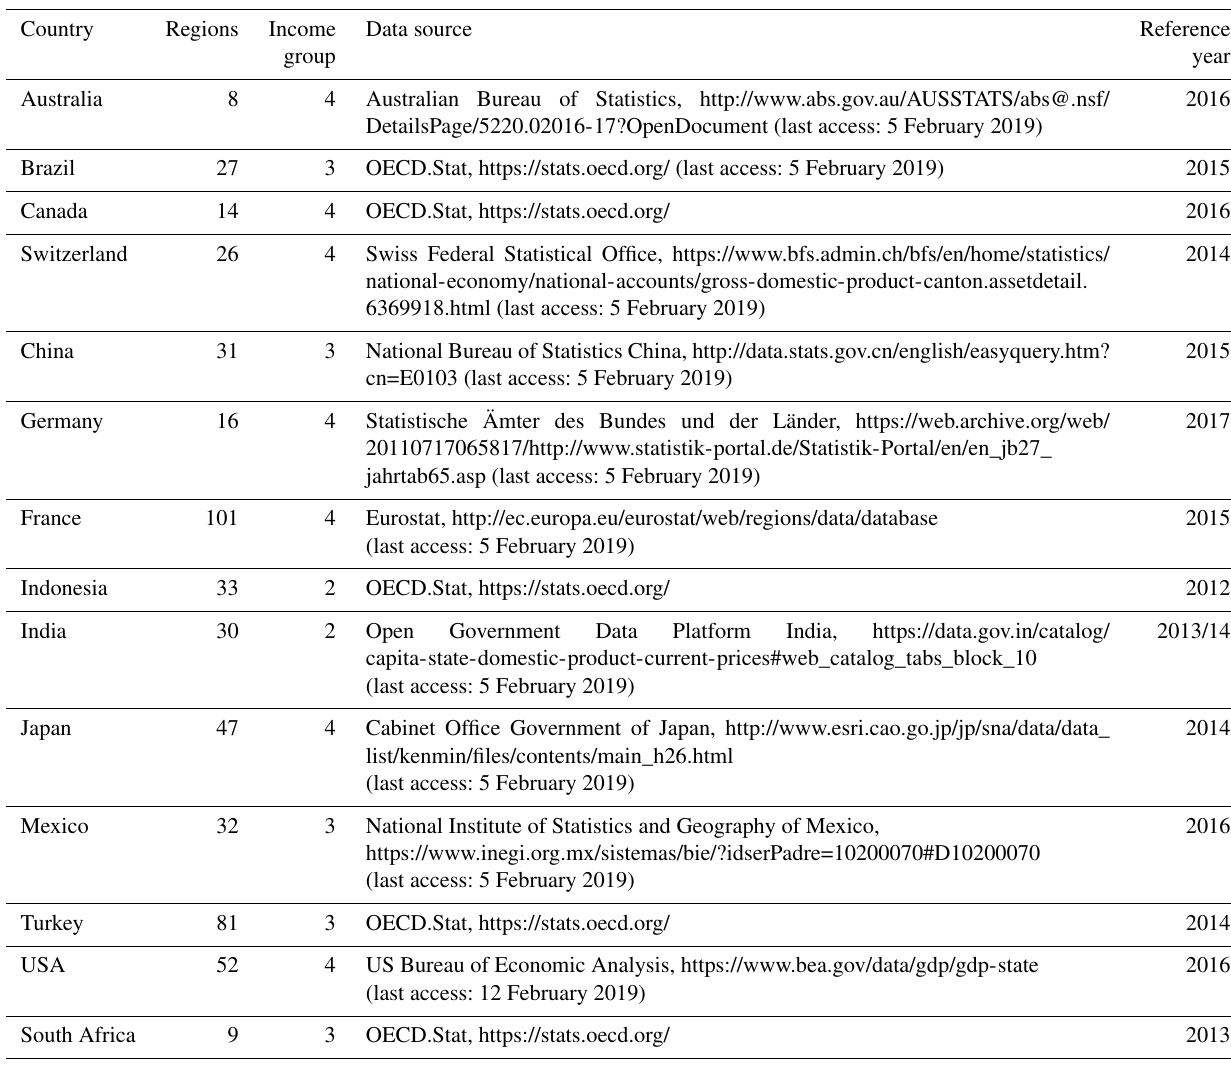
Table A1. List of countries used for evaluation with the number of regions on the administrative level 1, the World Bank income group 2016, and GRP data source with URLs as accessed in January 2019. The income groups are low income (1), lower-middle income (2), upper-middle income (3), and high income (4). In total, GRP data for 507 regions in 14 countries were